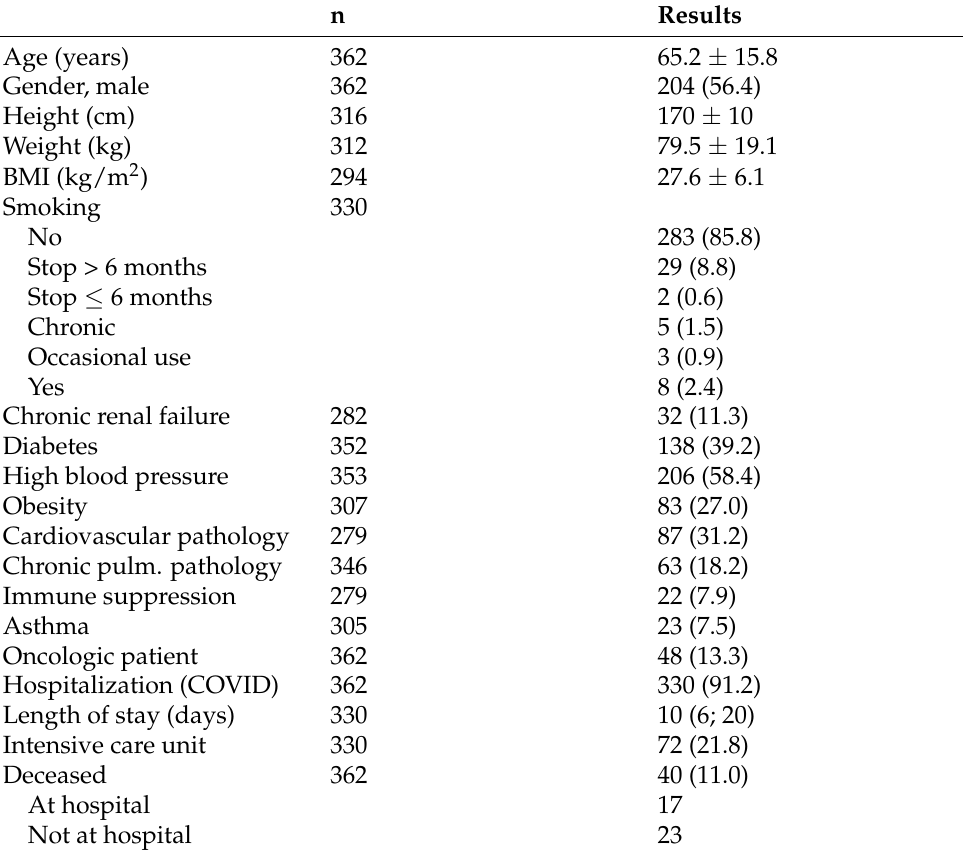
Table 2. Patients’ characteristics (N =